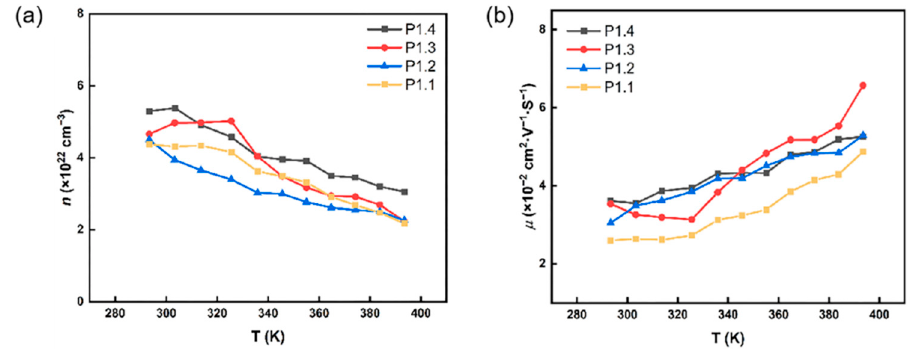
Figure 5. Temperature dependence of ( a ) carrier concentration ( n ) and ( b ) mobility ( µ ) of P1.1, P1.2, P1.3, and P1.4 films.